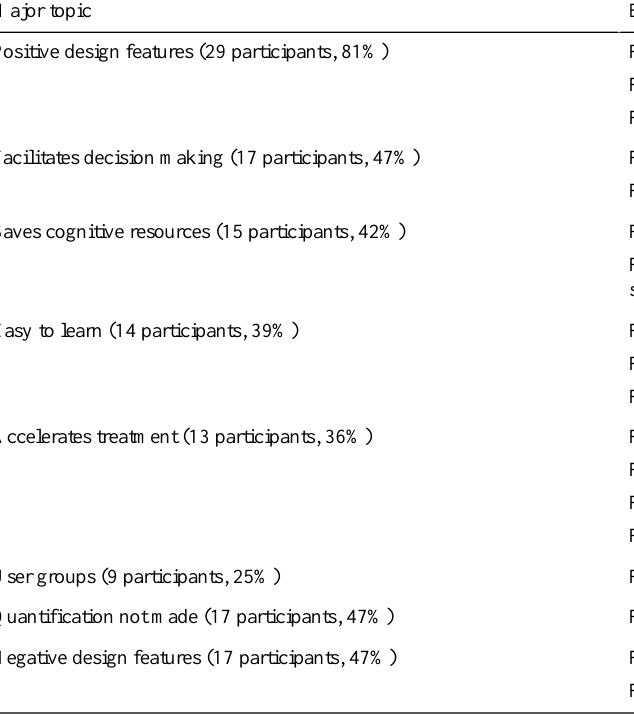
Table 2. The major topics with participant count, percentages, and examples